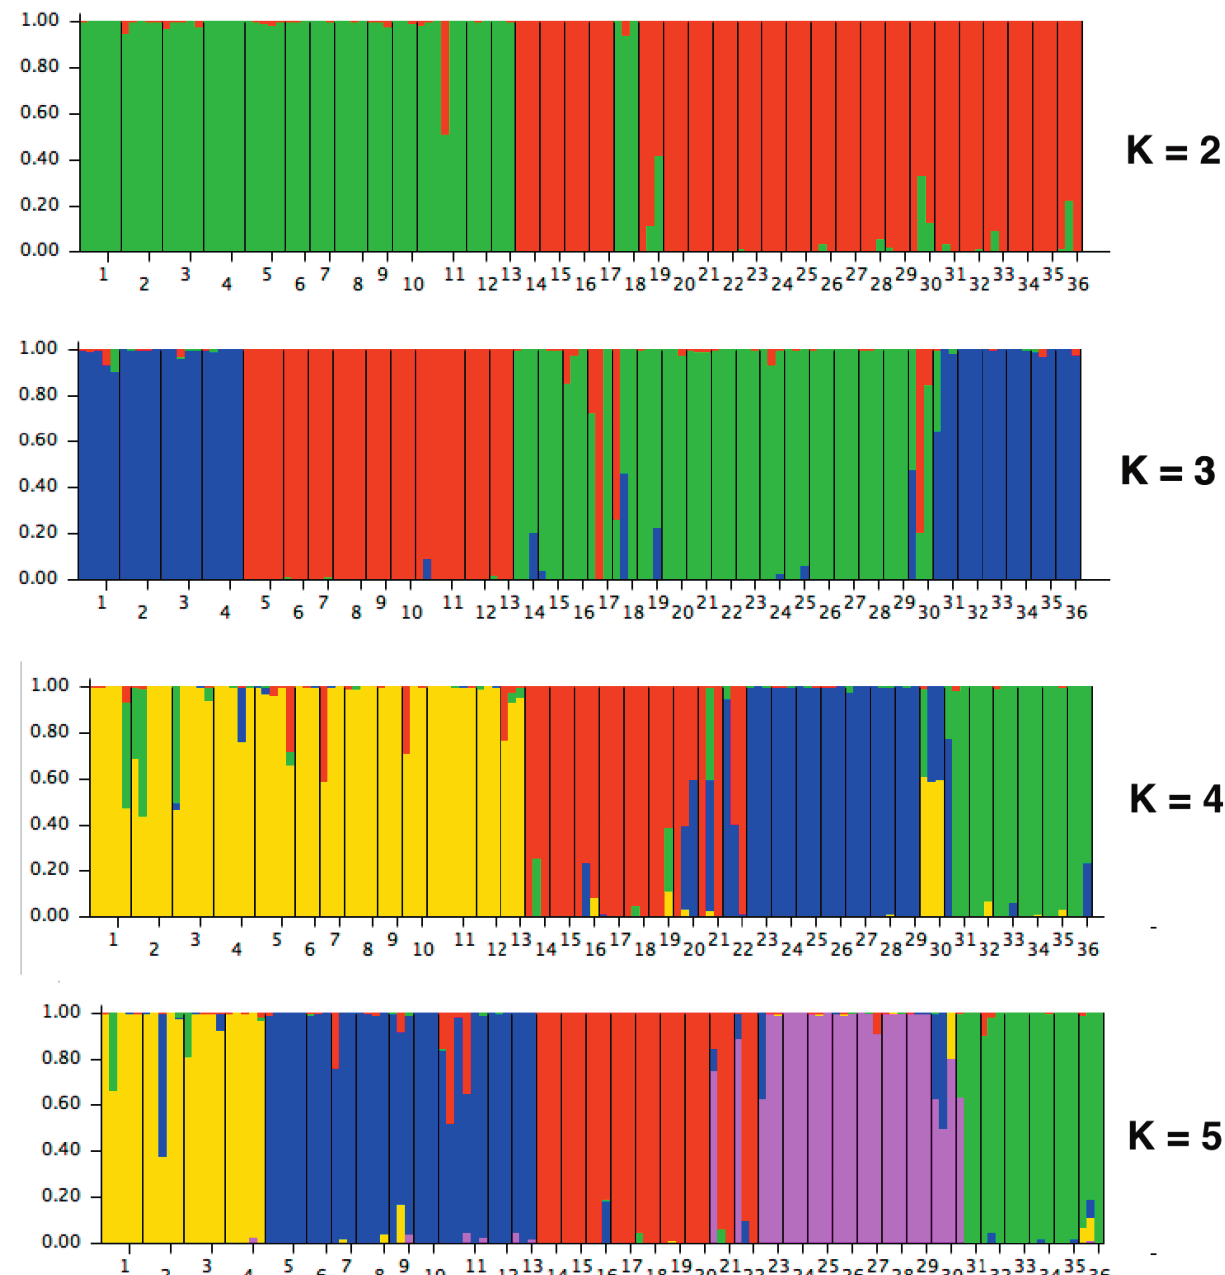
Figure 5. STRUCTURE plot of date palms studied based on K =